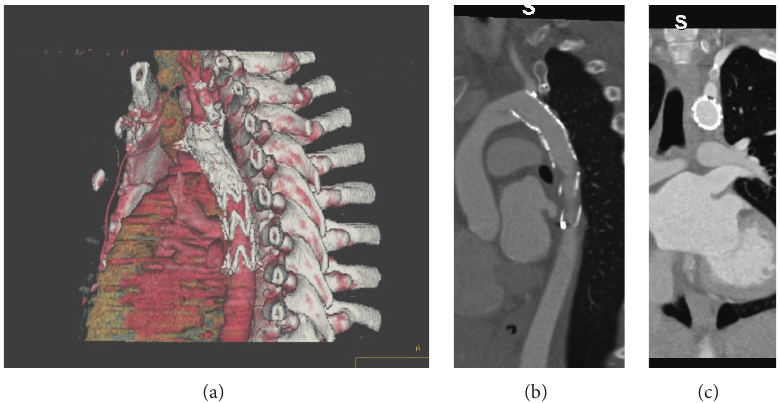
Figure 3: (a) Thoracic stent graft partially covering the origin of the left subclavian artery-3D reconstruction. (b) The stent graft partially covers the origin of the left subclavian artery. (c) The stent graft partially covers the origin of the left subclavian